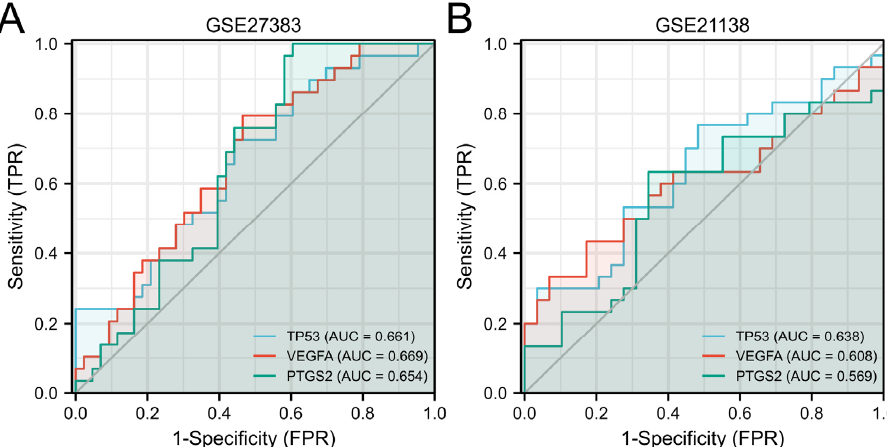
Figure 8. A diagnostic assessment of three hub genes. ( A ). GSE27383; ( B ). GSE21138. When three hub genes were utilized as distinct diagnostic indications, the ROC curve data demonstrated that TP53 measured in the GSE27383 was 0.661 (95% confidence inter- val (CI), 0.533–0.789), VEGFA was 0.669 (95% confidence interval (CI), 0.544–0.794) and PTGS2 was 0.654 (95% confidence interval (CI), 0.529–0.780). In GSE21138, TP53 was 0.638